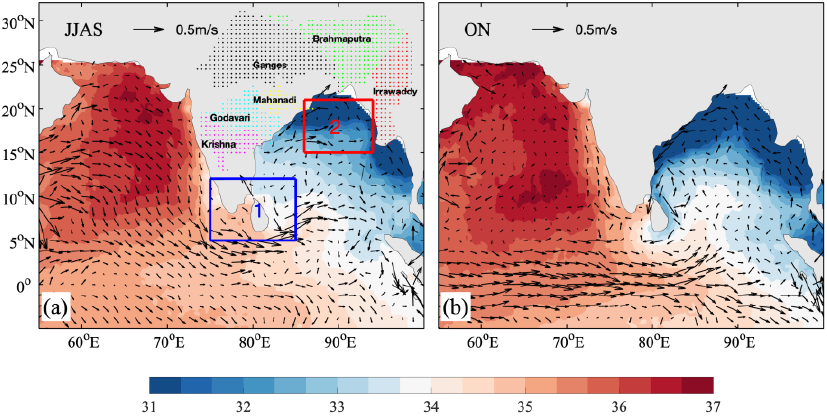
Figure 2. Composites of the distribution of SMOS sea surface salinity (shaded; psu) and OSCAR currents (vectors; m/s) ( a ) from June to September, ( b ) in October and November for 2010–2019. The blue box indicates region 1 around Sri Lanka (75–85 ◦ E, 5–12 ◦ N), and the red box indicates region 2 in the northern BoB (86–94 ◦ E, 15–21 ◦ N). The distribution of rivers is marked with dots (red, green, white, yellow, blue, and pink represent Irrawaddy, Brahmaputra, Ganges, Mahanadi, Godavari, and Krishna,